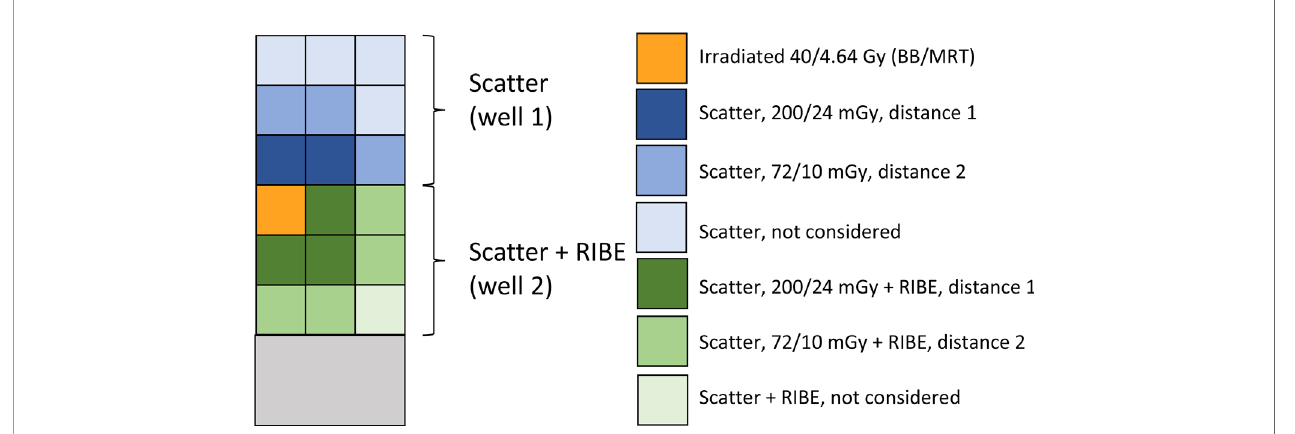
FIGURE 1 | Experimental set-up for BB and MRT irradiations. The image is a schematic presentation of a two-well chamber slide; the chambers are divided by a plastic separator. Each well is considered as nine 8x8mm zones, with only cells in the upper top left zone of well 2 (orange) being irradiated. Well 1 was not irradiated. Because well 1 was physically separated from the irradiated well 2, it was only used for the assessment of DDR induced by scattered radiation. In well 2, irradiated and non-irradiated cells shared the medium, therefore the non-irradiated cells were exposed to both scattered radiation and bystander signalling from the irradiated cells. g -H2AX foci per cell values in cells from the non-irradiated well 1 at different distances from the irradiated site were compared to the commensurate distance values in the irradiated well 2 (distance 1: next to the irradiated area, dark blue and dark green; distance 2: far from the irradiated area, blue and green). The distances that did not have a suf fi cient match (light blue and light green), were not considered. Average doses delivered by the beam or scattered radiation are shown in right part of the fi gure for BB and MRT